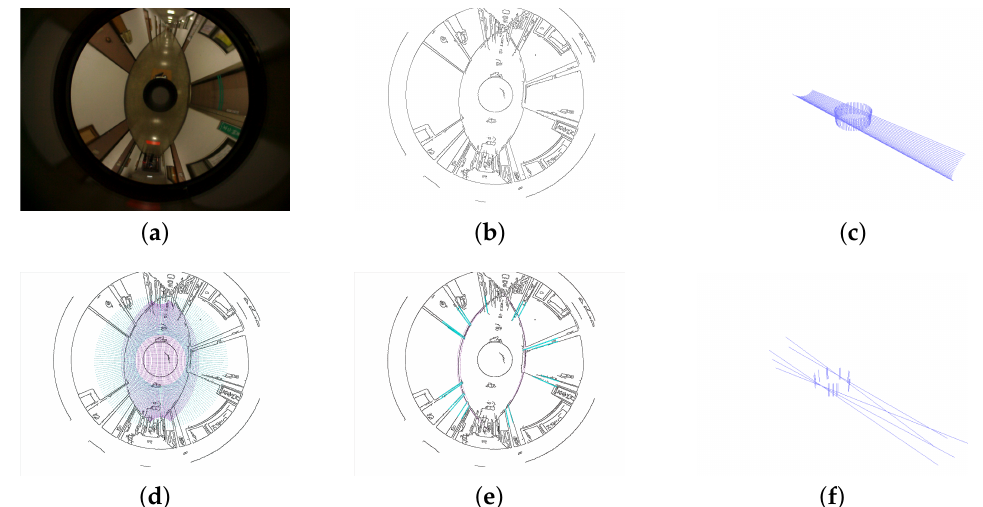
Figure 11. The mobile robot self-localization using omnidirectional images. ( a ) An input real image; ( b ) the edge detection result; ( c ) the parallel horizontal and vertical lines constructed in the vertical space; ( d ) the overlay of the edge image with the virtual lines projected on the omnidirectional image; ( e ) the identified horizontal and vertical lines in the real world scene; ( f ) the corresponding lines in the virtual space for localization